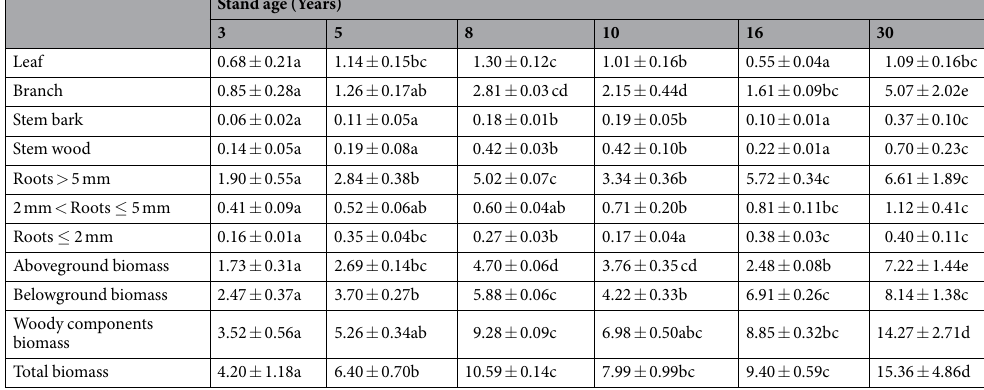
Table 3. Biomass carbon density for C. intermedia plantation stands of different ages (t·ha − 1 ). Values followed by different lowercase letters indicate significant differences among stand ages according to Duncan’s multiple range test ( P < 0.05). The values are the means ± SE (n = 3).